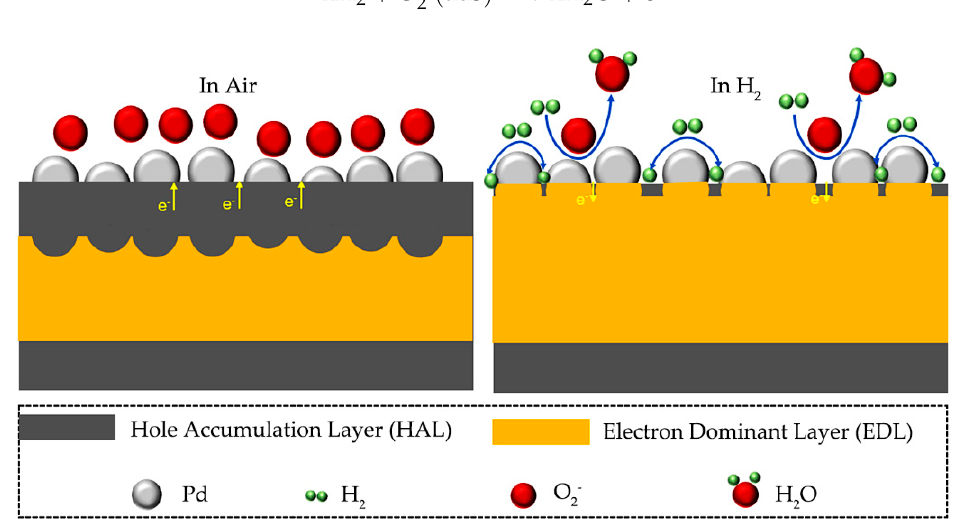
Figure 7. Schematic diagram of response mechanism.